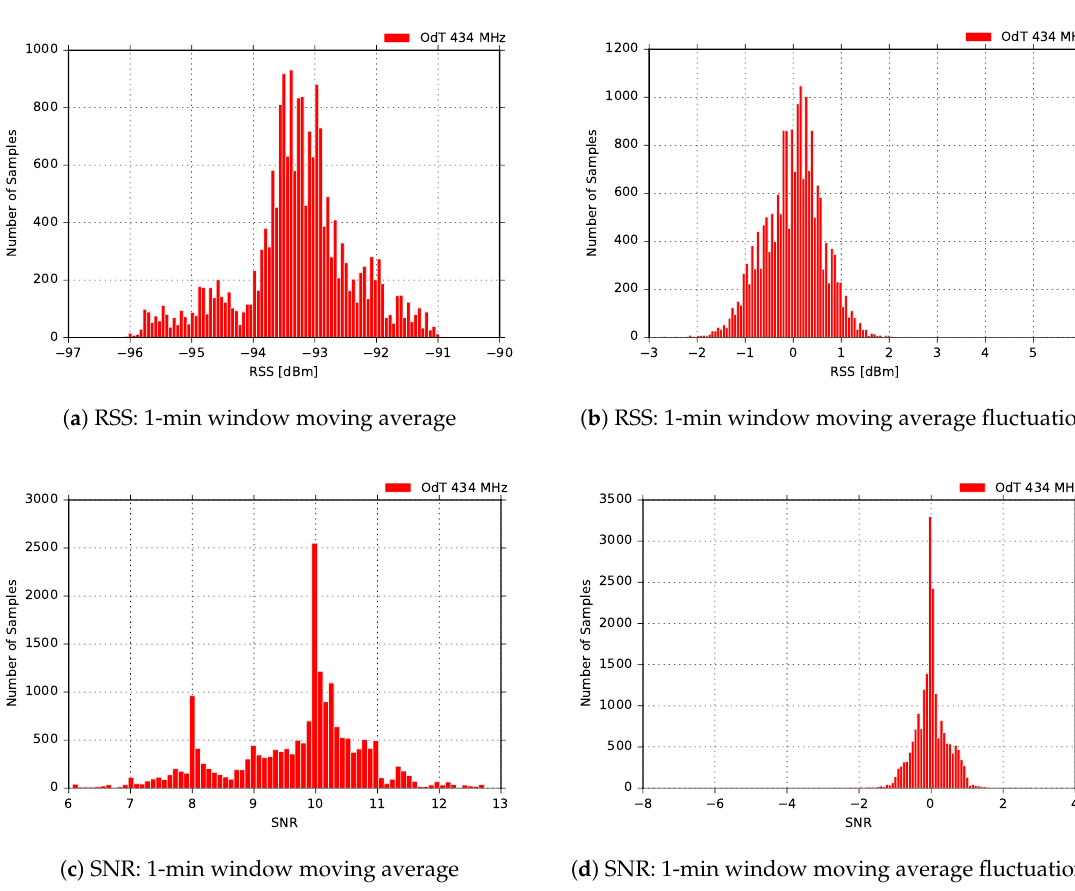
Figure 19. RSS, SNR, and PRR for ODT at 434MHz in LOS channel conditions for BW = 125kHz, SF = 12, and CR = 4/6.